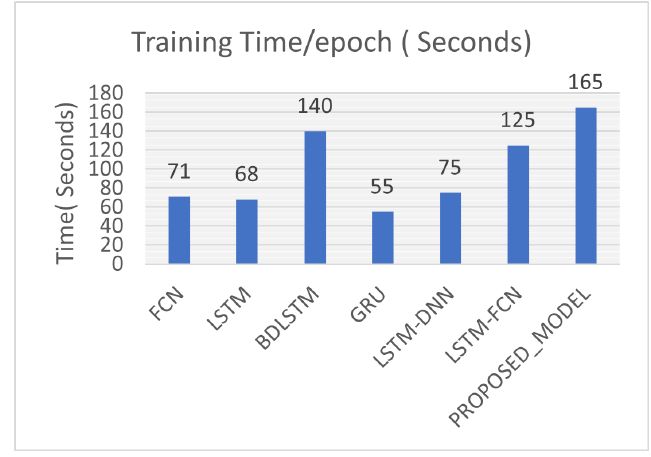
Figure 7. Training time per epoch vs. time (seconds).